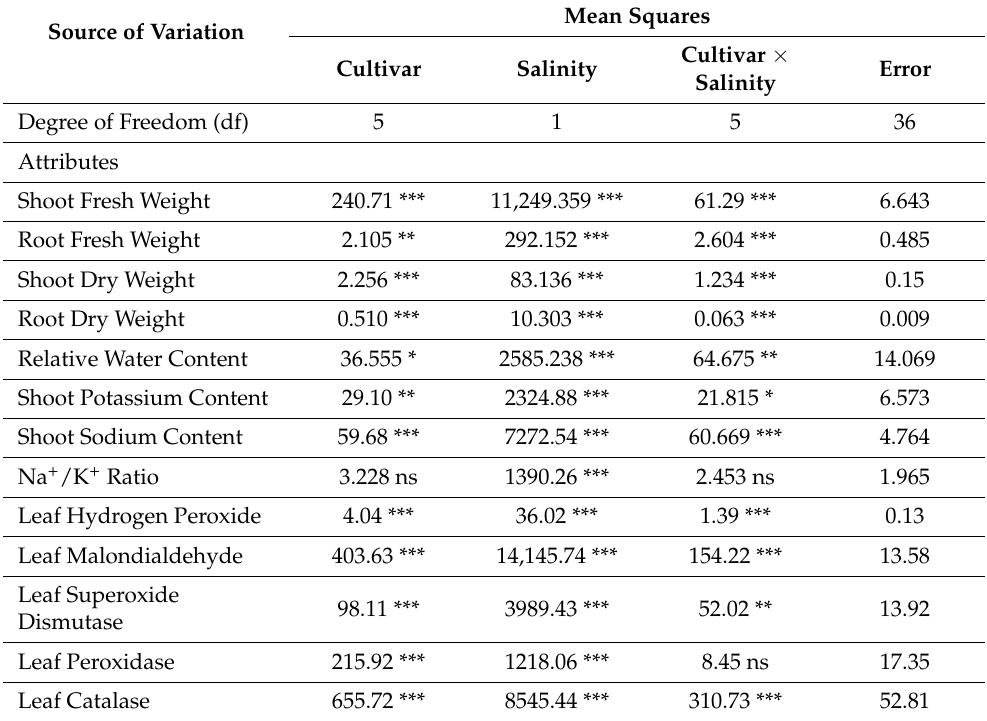
Table 1. Mean squares from the analysis of variance (ANOVA) of the data for growth attributes, rela- tive water content, accumulation of K + and Na + , H 2 O 2 as reactive oxygen species (ROS), membrane damage as oxidative stress, and activities of antioxidant enzymes of six cultivars of canola ( B. napus L.) grown under control (0 mM NaCl) or saline (200 mM NaCl) conditions. Mean Squares Source of Variation Cultivar × Cultivar Salinity